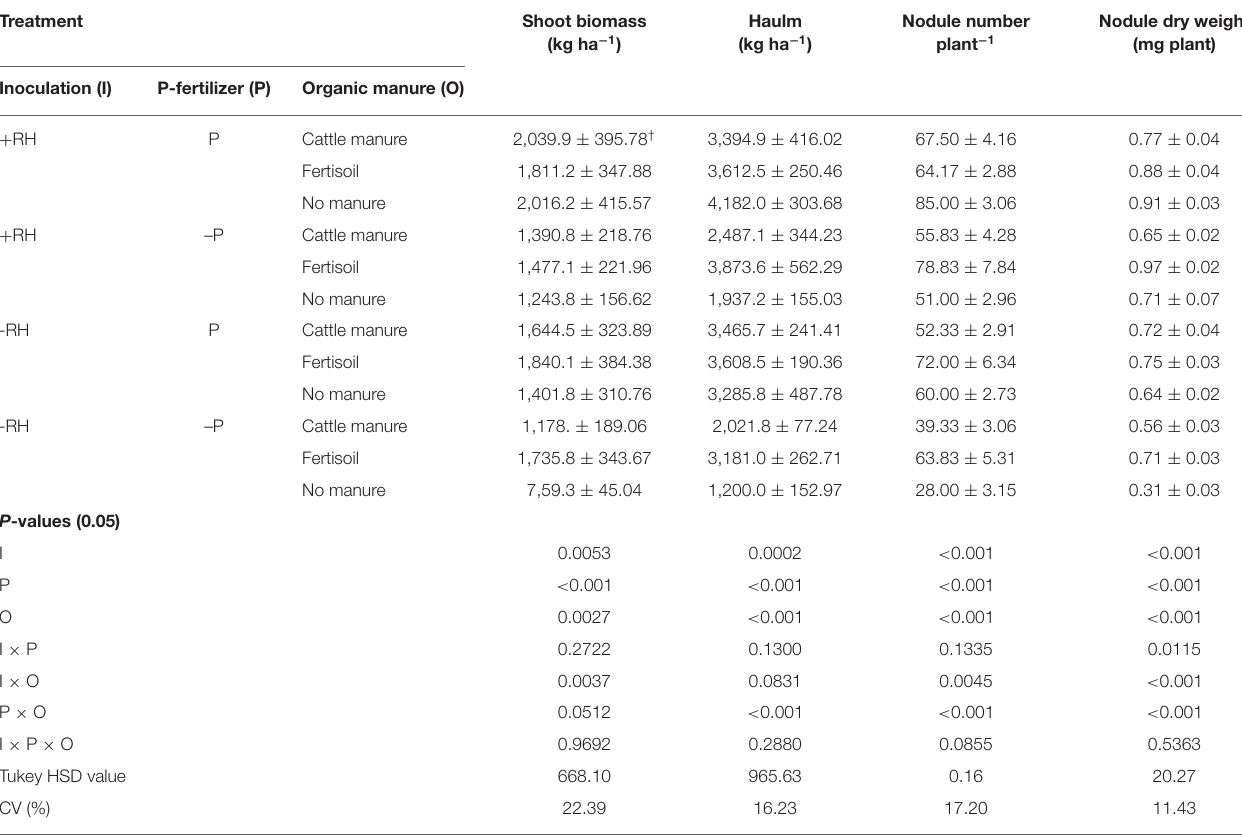
TABLE 2 | Soybean shoot biomass, Haulm, and nodulation as affected by the application of rhizobia, P-fertilizer, and organic manure. Treatment